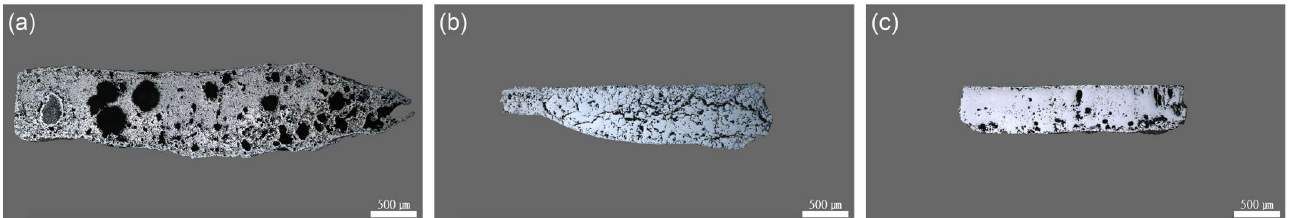
Figure 13. Comparison of flake hammer scale according to thickness: ( a ) flake hammer scale (No. 2), ( b ) flake hammer scale (No. 3), ( c ) flake hammer scale (No. 4).